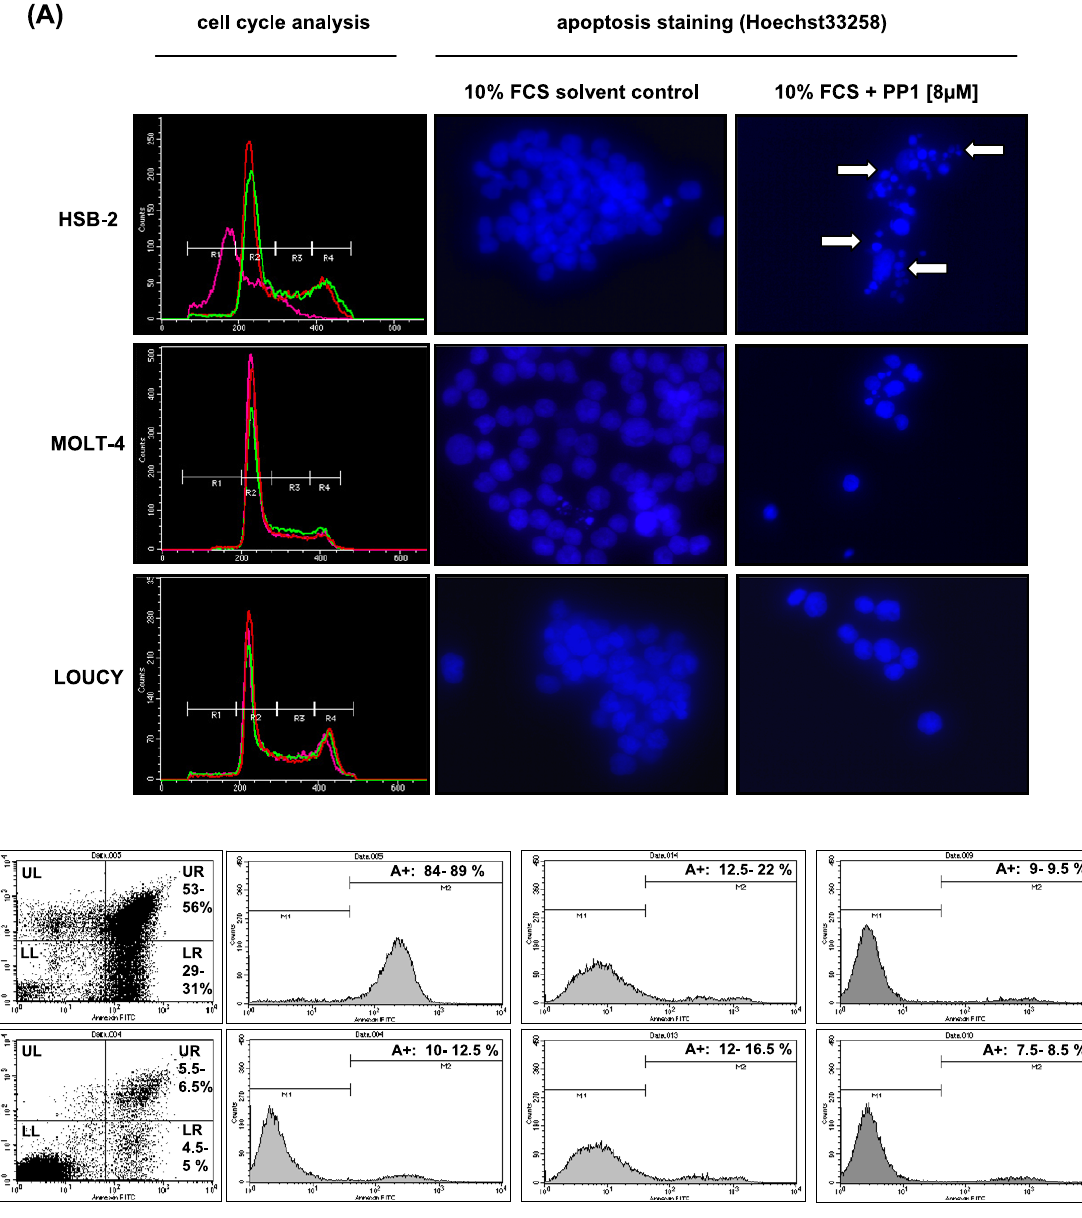
Fig. 4. Analysis of the growth inhibitory mechanism after PP1 treatment in human T-ALL cell lines. (A) Cell cycle analysis and apoptosis staining after PP1 exposure with Hoechst33258 performed with the cell lines HSB-2 (highly PP1 sensitive), MOLT-4 (PP1 sensitive) and LOUCY (PP1 insensitive). Cells cycle analyses were performed five times in triplicates as described in Section 2 (R1 – SubG 1 / 0 -fraction, R2 – G 1 / 0 -phase fraction, R3 – S-phase fraction, R4 – G 2 /M-phase fraction; red – starvation control; green – proliferative control, purple – PP1 treated cells; white arrow indicates apoptotic bodies). Summary of cell cycle analysis is shown in Fig. 3B. (B) Apoptosis was further determined by flow cytometry analysis of annexin-V/propidium iodid (PI) stained cells as described in Section 2. Representative FACS analyses are shown for the T-ALL cell lines HSB-2 (PP1 highly sensitive), MOLT-4 (PP1 sensitive), LOUCY (PP1 insensitive). Results from two independent experiments are given as range of the relative cell distribution in the dot-plots and histograms, respectively. Legend: Dot-plots: y -axis: PI, x -axis: annexin-V; lower left quadrant (LL) – vital cells, lower right quadrant (LR) – early apoptosis, upper right quadrant (UR) – late apoptosis, upper left quadrant (UL) – detritus; histograms: y -axis: event counts, x -axis: annexin-V, M1 – annexin-V negative cells, M2/A + – annexin-V positive